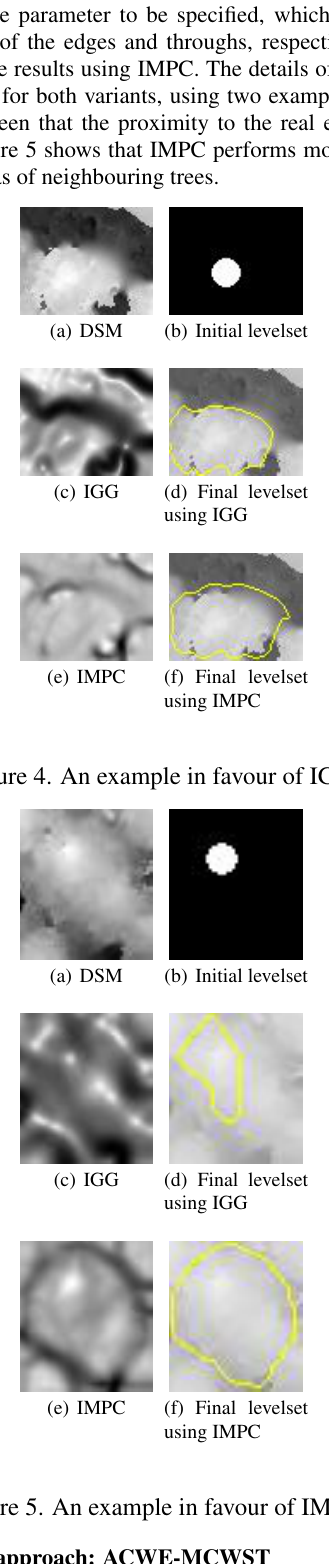
Figure 5. An example in favour of